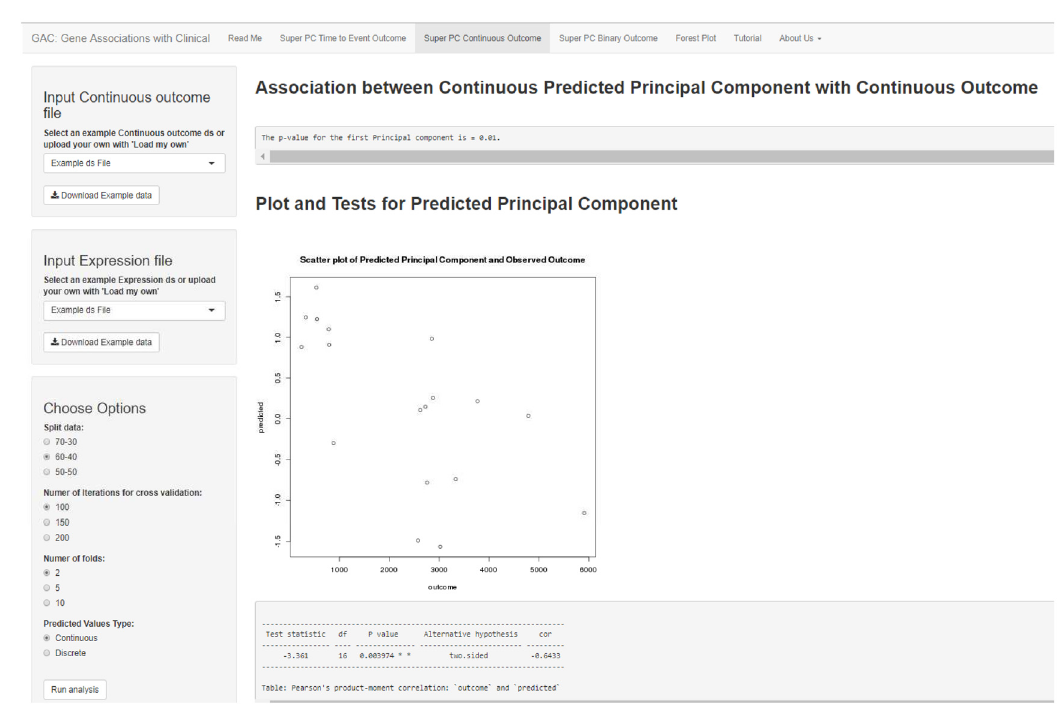
Figure 2. SuperPC continuous outcome. The interface shows an example SuperPC for continuous outcome. Similar to Figure 1, the user can choose the appropriate settings using the left panel and view the results of the analysis to the right. The association of the continuous outcome with the predicted principal component is summarized using a scatter plot (as seen). The user can alternatively choose to summarize these results through boxplots by dichotomizing the predicted principal component based on the median. As in Figure 1, the univariate regression scores and plots are available for download in the left